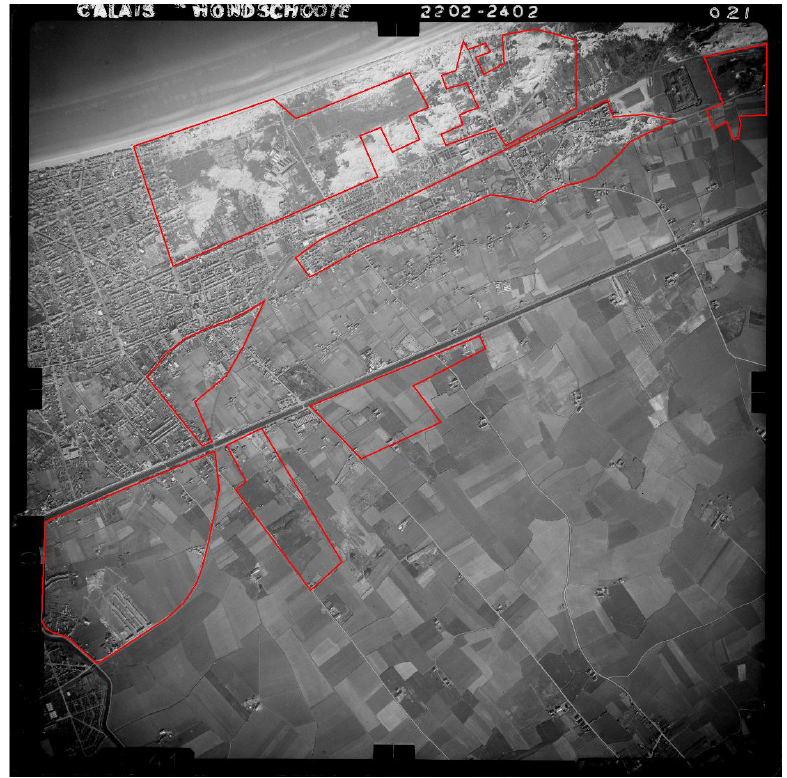
Figure 3. East part of Dunkirk, Leffrinckoucke, in 1957, with shapes of future extensions and densification of the city highlighted in red. Picture of the service “remonter le temps” from the French National institute of Geographic and Forest Information (IGN).